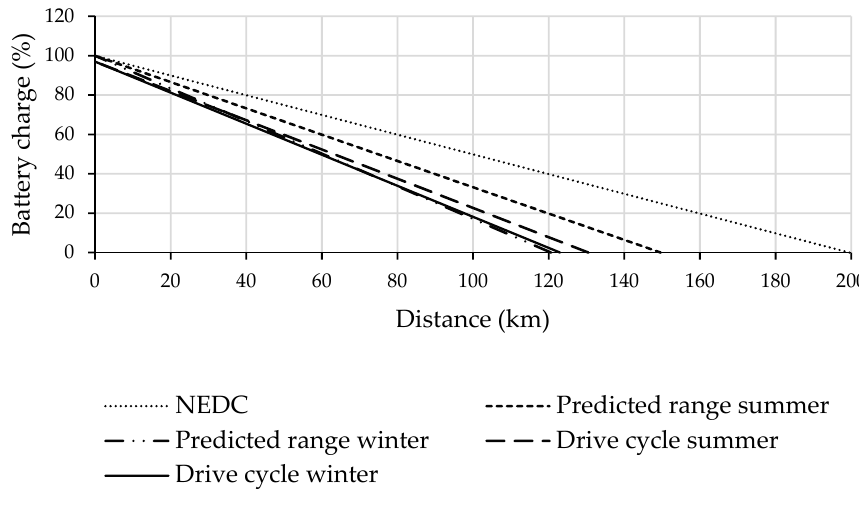
Figure 7. Nissan leaf range comparison.